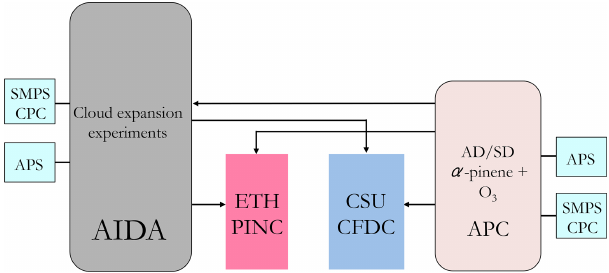
Figure 1. Experimental schematic of INP and aerosol sampling and sizing by cloud chambers and counting instruments at the AIDA facility at the Karlsruhe Institute of Technology during the ACI- 03 workshop in October 2009. APS: aerodynamic particle sizer, SMPS: scanning mobility particle sizer, CPC: condensation particle counter. See text for details on AIDA, ETH PINC and